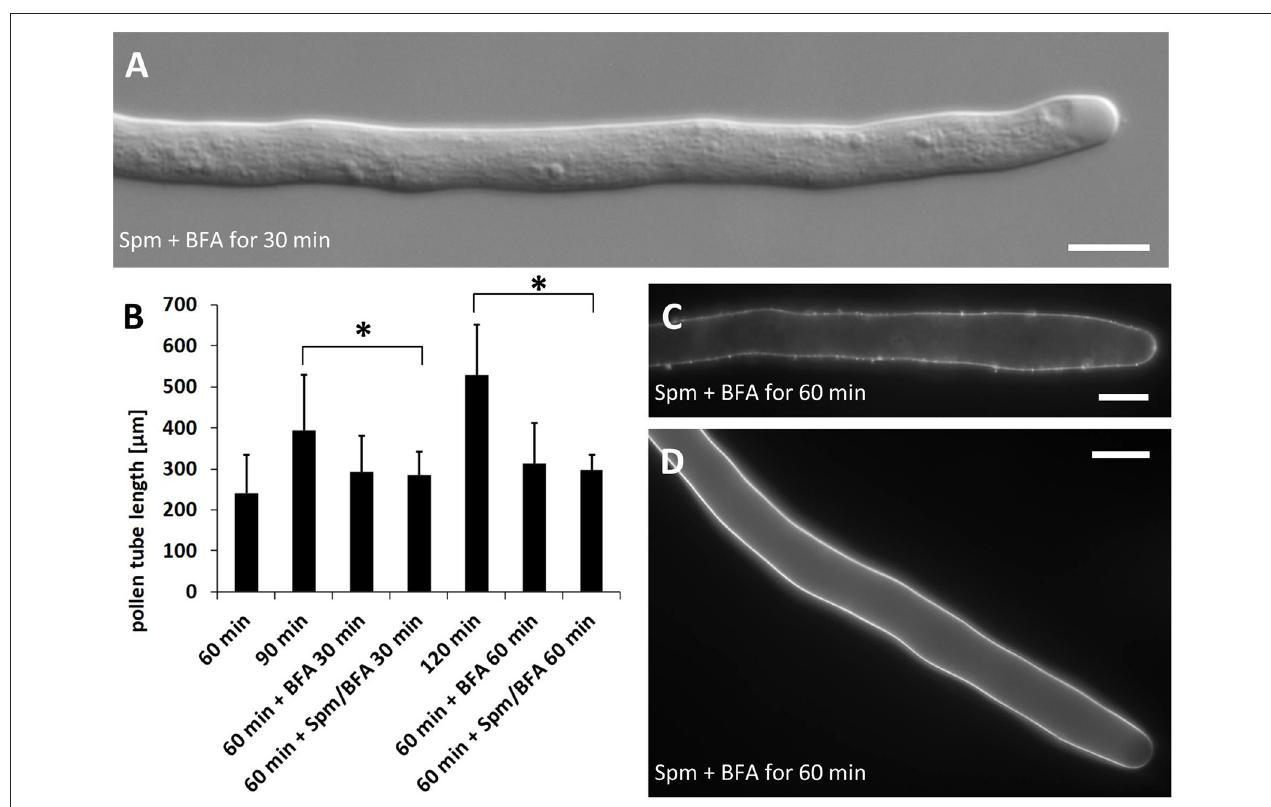
FIGURE 8 | Effects of treatment with Brefeldin A (BFA) and Spm on pear pollen tube length and cell wall components. (A) A DIC view of 30 min-treated pollen tubes showing no defects in tube morphology. (B) Growth rates of control pollen tubes and of either BFA- or Spm + BFA-treated pollen tubes. The 60-min stage (first bar on the left) represents pollen tube growth before addition of chemicals. Pollen tubes were supplemented with BFA or Spm + BFA for an extra 30–60min or they were grown under control conditions. The asterisk indicates that the measurements within square brackets are significantly different; in particular, data of treated pollen tubes are always significantly different compared to controls immediately to the left. Statistical analysis was performed using one-way ANOVA. (C) Labeling of pectins by PI. Pectins appear uniformly distributed. (D) Staining of callose by aniline blue. Callose is distributed as in controls and is absent in the very tip region. Bars: 10 µ